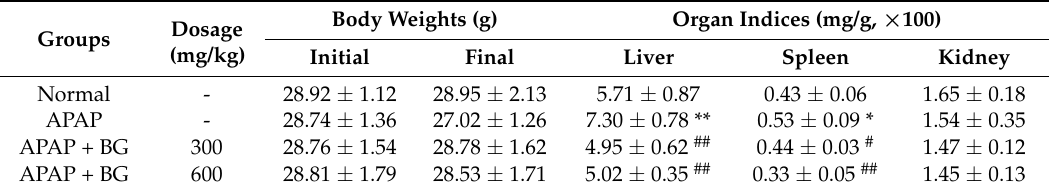
Table 1. Effects of BG on body weights and organ indices in mice.